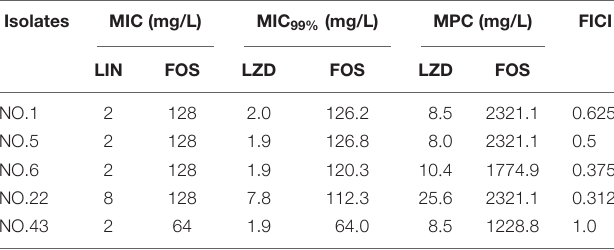
TABLE 1 | MIC 99% s and MPCs of two antimicrobial agents alone for five selected Enterococcus strains.